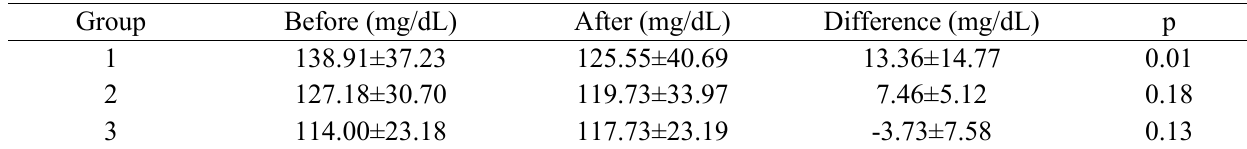
Table 5. Mean of LDL-C levels before and after intervention